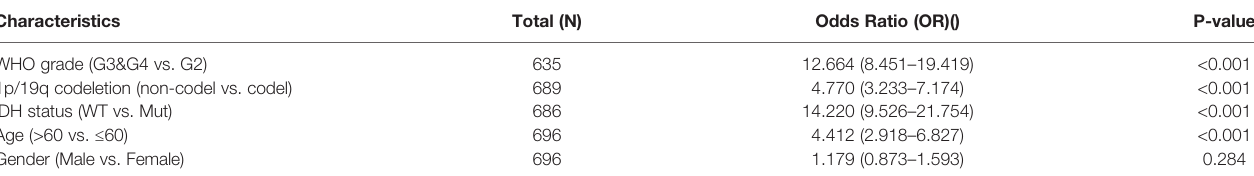
TABLE 3 | Logistic regression analysis of ASF1B expression.